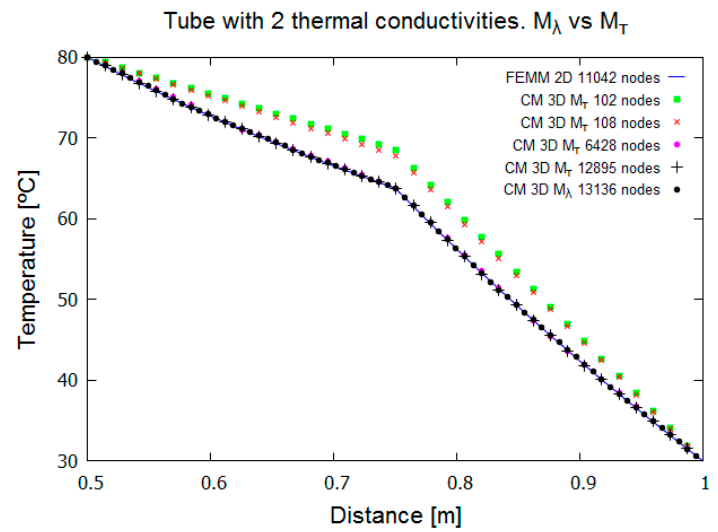
Figure 10. Temperatures in the tube with two thermal conductivities using [ M τ ] .